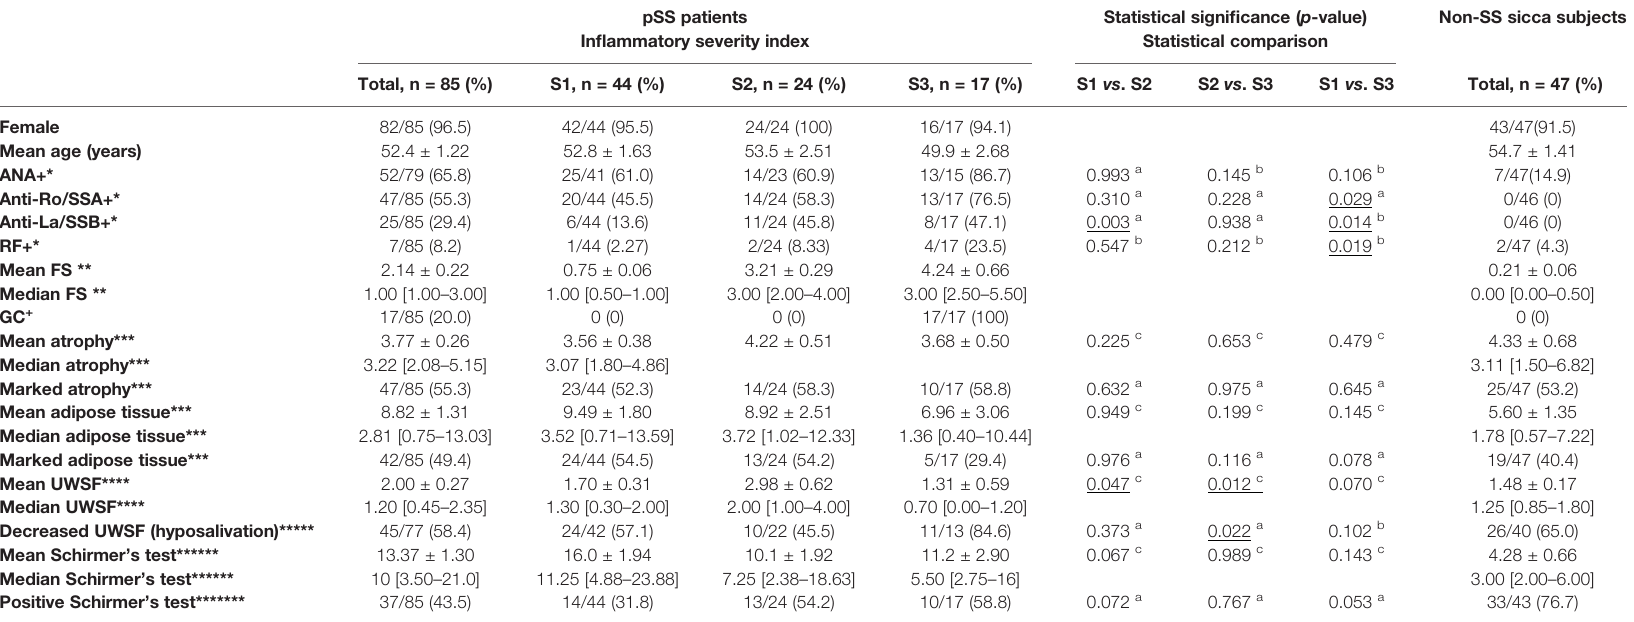
TABLE 1 | Mean/median values and number (%) of all patients and non-SS control subjects in the total sample size positive for the clinical and histopathological characteristics.